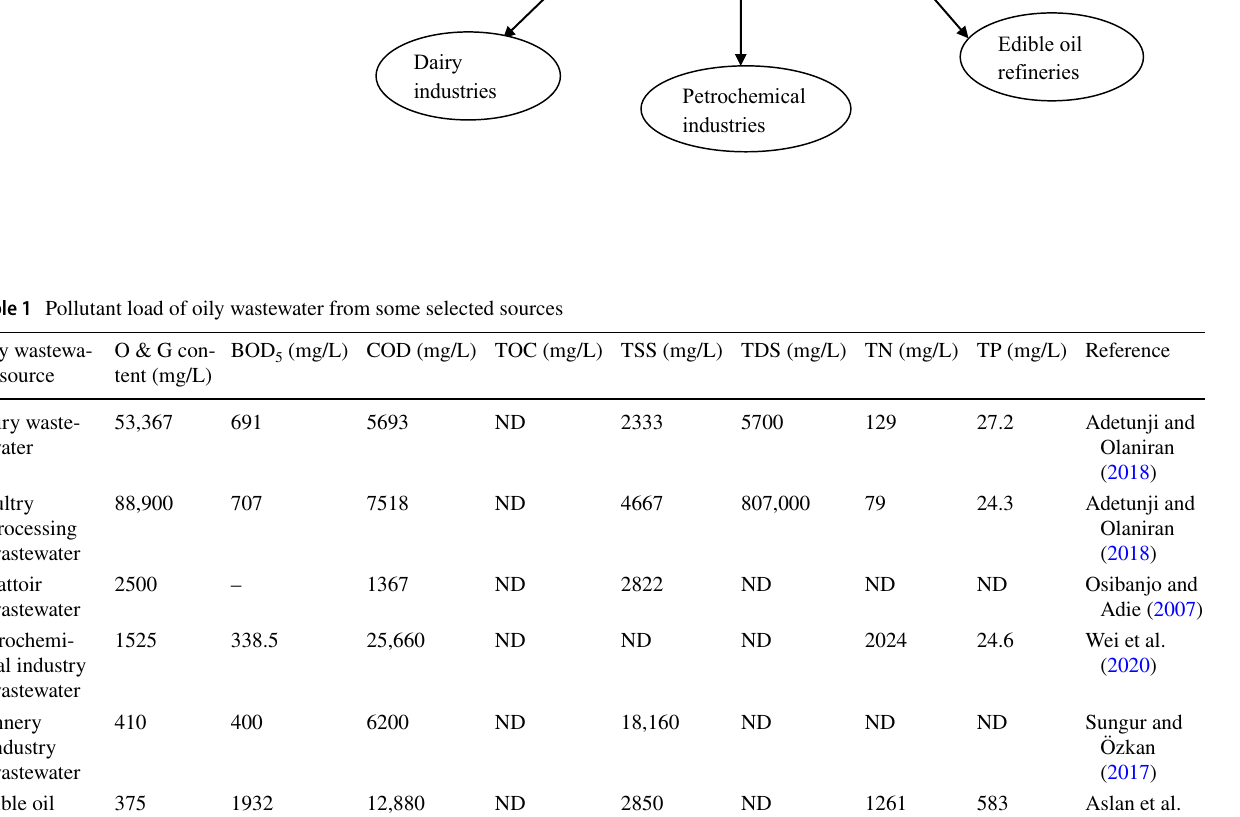
Oily wastewater sources